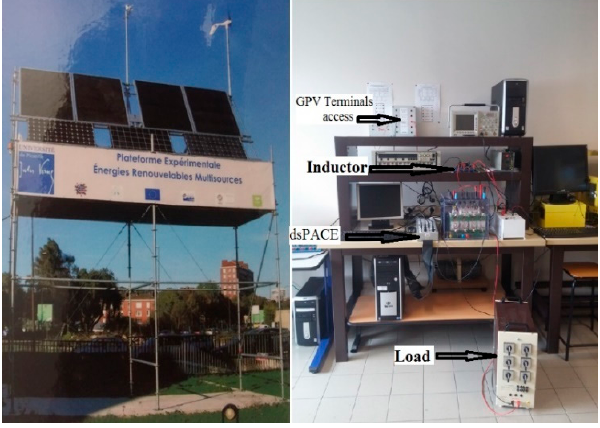
Figure 14. Hardware materials used in experimental tests.